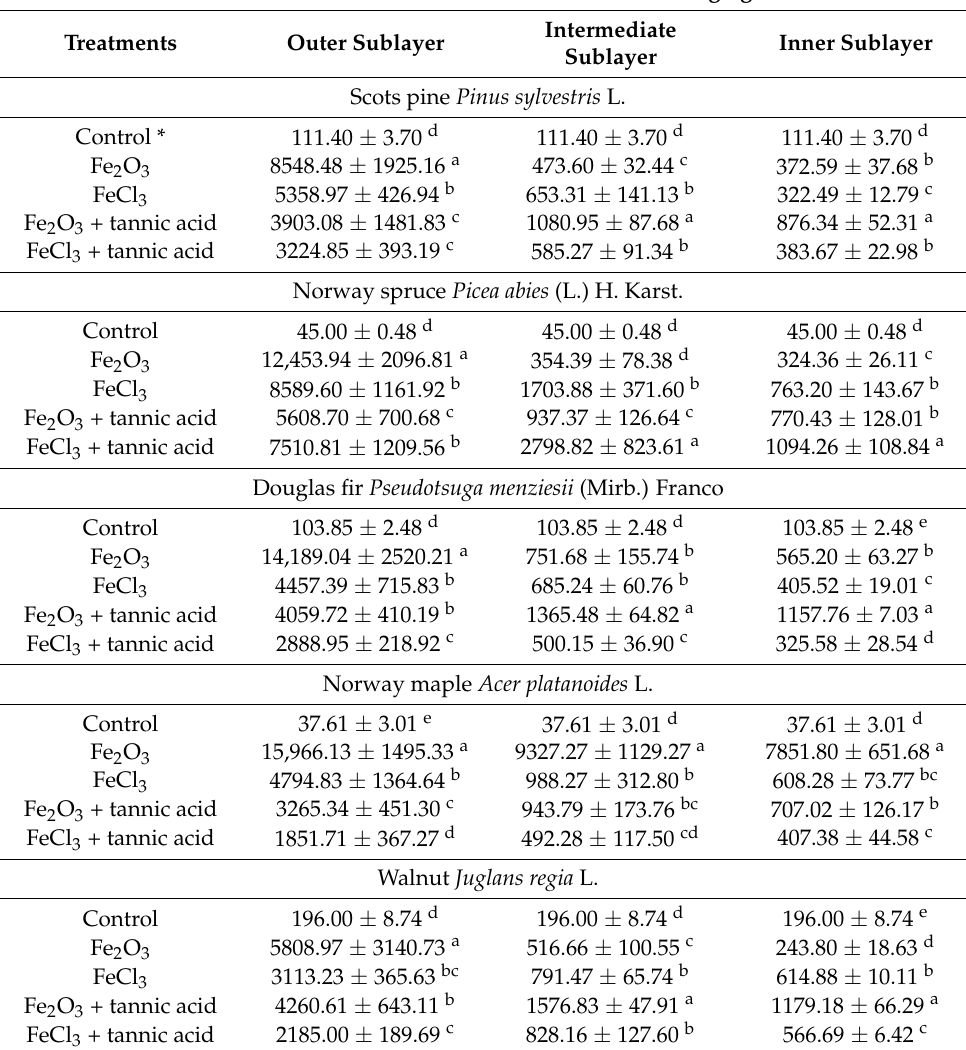
Table 2. Mean Fe concentration (mg kg − 1 ) in sublayers (outer, intermediate, and inner wood layers with the thickness of 2 mm per layer) after the thermal treatment. Different letters a, b, c, d and e given next to the mean value show statistically significant differences between the treatments for each tree species at p < 0.05 ( n =